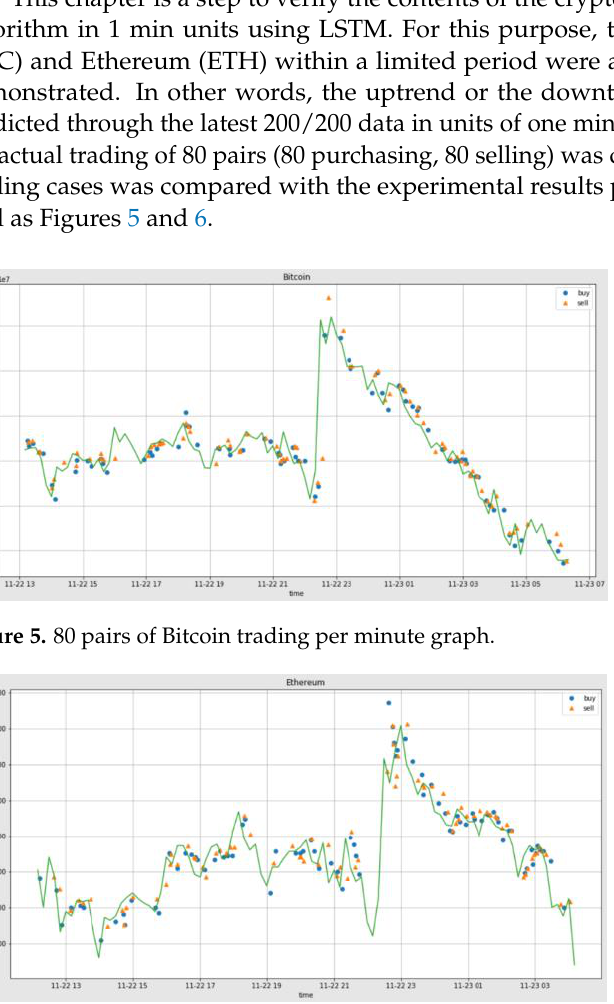
Figure 6. 80 pairs of Ethereum trading per minute graph.